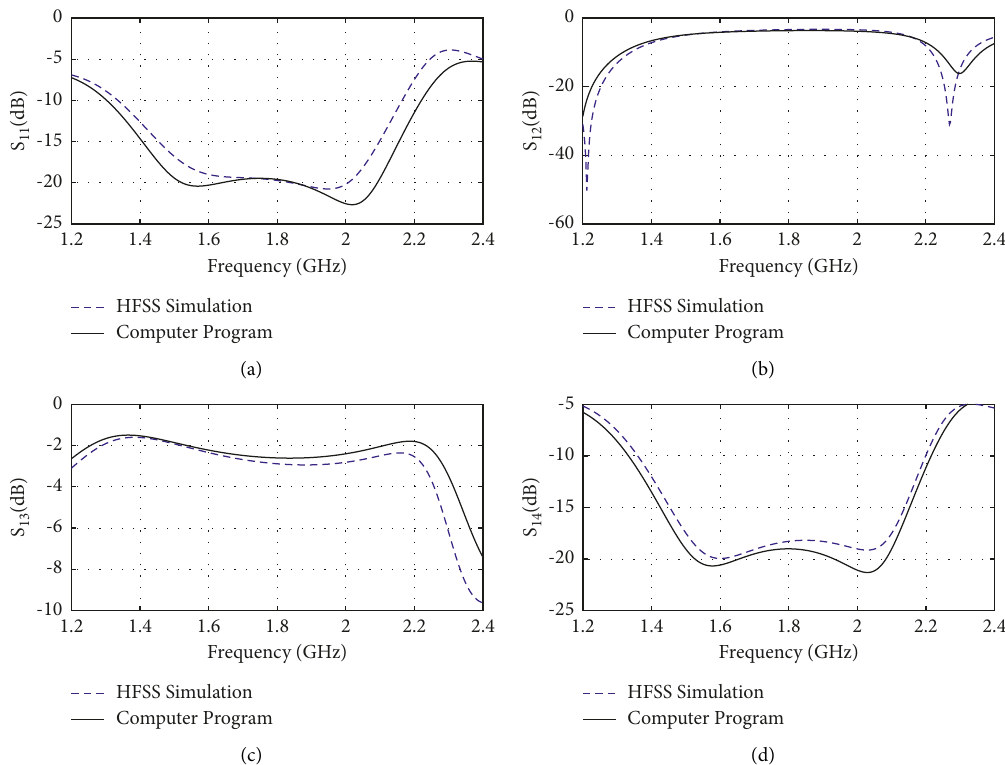
Figure 10: Frequency response of 3dB ATRD coupler. (a) Reflection Loss; (b) Coupling coefficient; (c) Through coefficient; (d) Isolation coefficient.